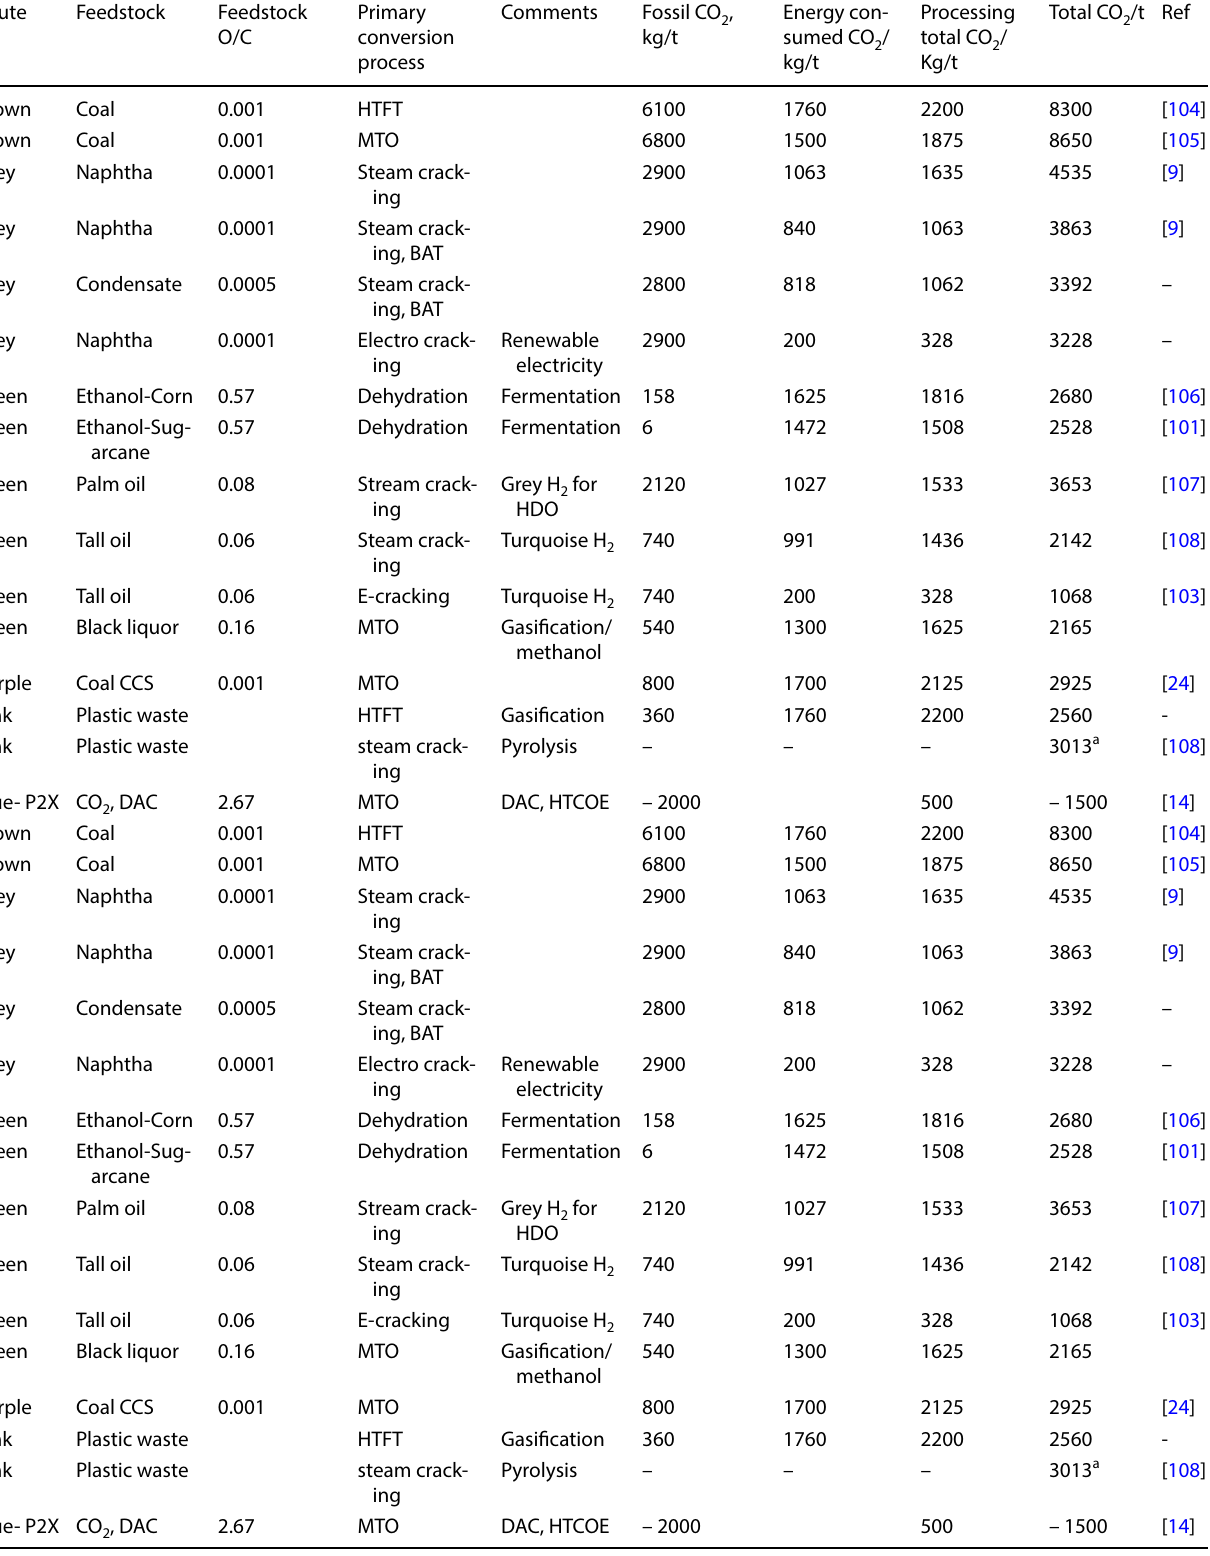
Table 1 Comparison of carbon intensity of alternative paths for olefin